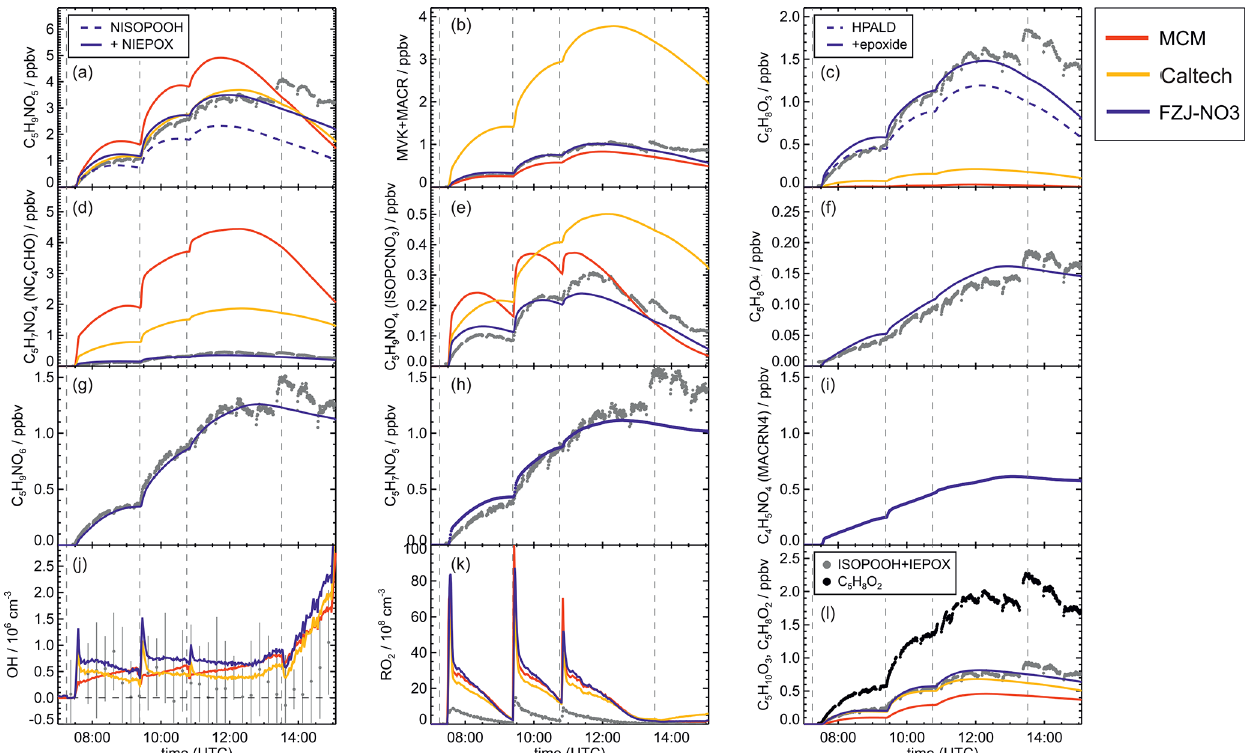
Figure 5. Comparison of results from model calculations applying the different isoprene NO 3 chemistry mechanisms for the experiment on 13 August 2018 (Experiment 4), when the amount of oxidized isoprene was highest. MVK, MACR, NISOPOOH, ISOPCNO 3 and NC 4 CHO are produced from all mechanisms, whereas the other species are only produced from either 1,6-H-shift reactions or ring-closure reactions of nitrate alkoxy radicals only implemented in the FZJ-NO3 mechanism. Grey and black dots are measured values. Measured organic peroxy radical concentrations only include part of the total RO 2 because the LIF instrument cannot detect a fraction of nitrate RO 2 (Vereecken et al., 2021). Organic products were detected by the Vocus PTR-MS instrument, which was only calibrated for MVK and MACR. All other traces are scaled to match best the results from the FZJ-NO3